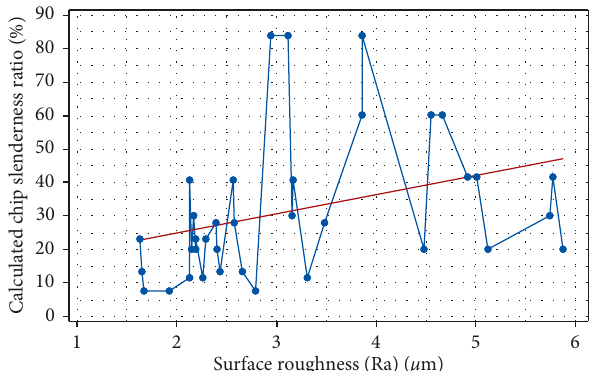
Figure 6: The effect of the calculated chip slenderness ratios on the surface